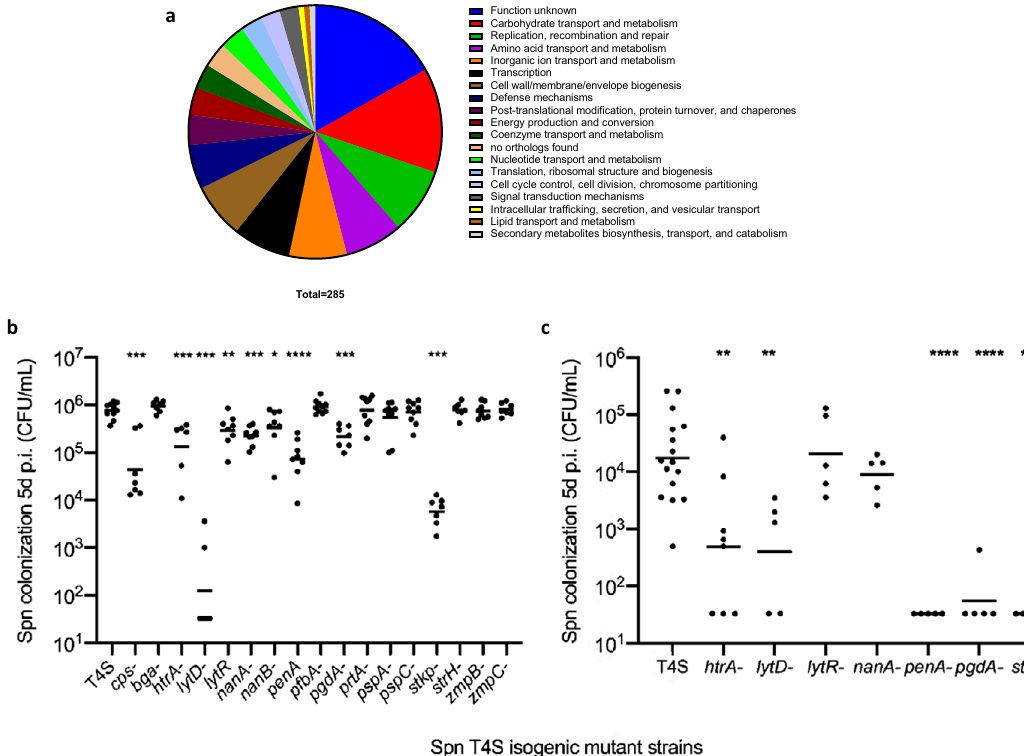
Fig. 1 Colonization by TnSeq mutants and analysis of candidate genes. a Functional annotation of genes identi fi ed in the TnSeq screen with diminished infant mouse colonization ( P < 0.05). b De fi ned mutants in the 16 genes identi fi ed in the TnSeq screen expressing antibody- binding targets were constructed and tested for their ability to colonize infant mice in comparison to the parental (T4S) and unencapsulated (T4 cps -) strain controls. c Mutants with diminished colonization of infant mice ( P < 0.01) were also tested in adult mice. Symbols represent colonization density (CFU/ml upper respiratory track lavage) of individual mice at 5 days post-infection with median values shown. Statistical comparisons using the Mann – Whitney test for each mutant were to T4S strain. * P < 0.05, ** P < 0.01, *** P < 0.001, **** P <